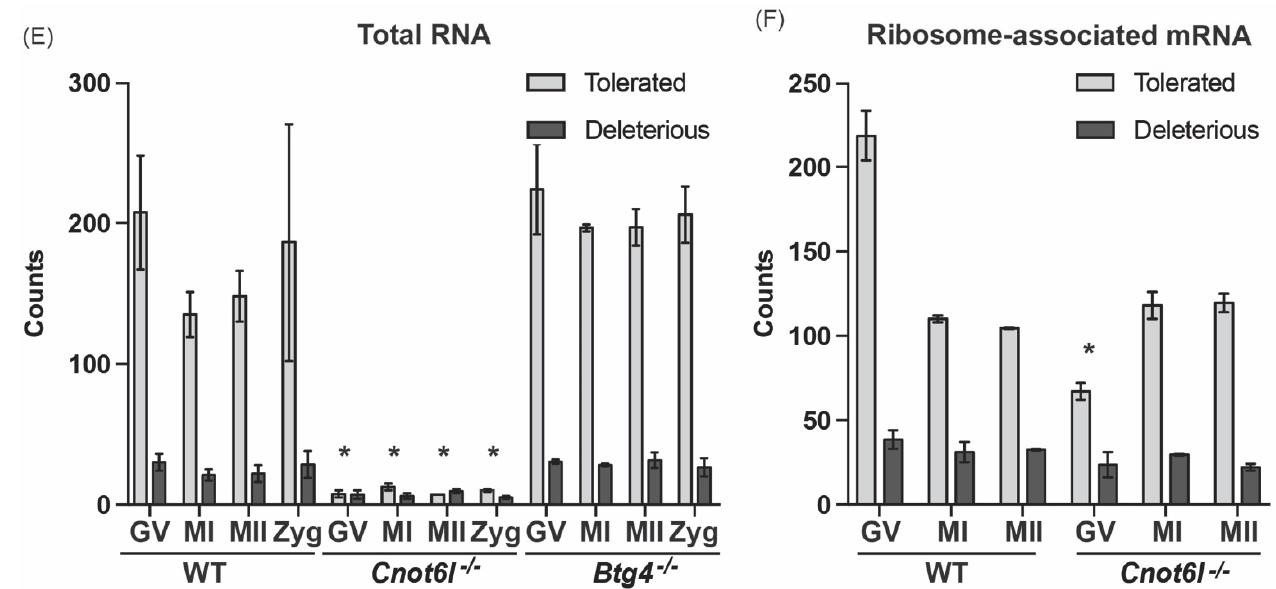
Figure 3. Consequences of inosine RNA modifications within CDS from WT, Cnot6l -/- , and Btg4 -/- oocytes, egg, and zygote transcripts. ( A , B ) Proportion of inosine modifications (percentage) in WT, Cnot6l -/- , and Btg4 -/- samples that result in nonsynonymous or synonymous changes was determined for all CDS inosine modified mRNA transcripts in total RNA ( A ) and ribosome-associated mRNA ( B ). ( C , D ) Proportion of tolerated and deleterious transcripts following Sorting Intolerant From Tolerant (SIFT) analysis of the inosine modified mRNA transcripts from WT, Cnot6l -/- , and Btg4 -/- samples in total RNA ( C ) or ribosome-associated mRNA ( D ). ( E , F ) Counts of tolerated and deleterious transcripts resulting from inosine RNA modifications from WT, Cnot6l -/- , and Btg4 -/- samples in total RNA ( E ) or ribosome-associated mRNA ( F ). * Means ± SEM within a panel are different ( p < 0.05); significance was determined using X2 tests or 2-way ANOVA. Only transcripts with TPM ≥ 1 were